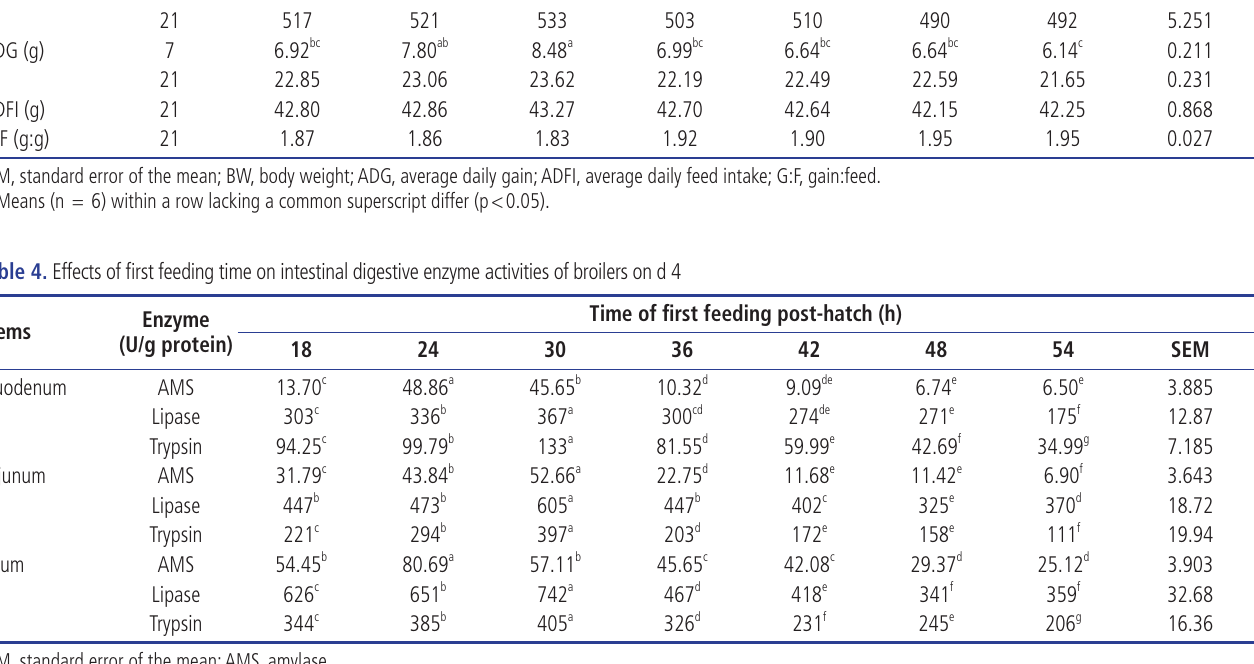
Table 2. Effects of first feeding time on growth performance in broilers Items